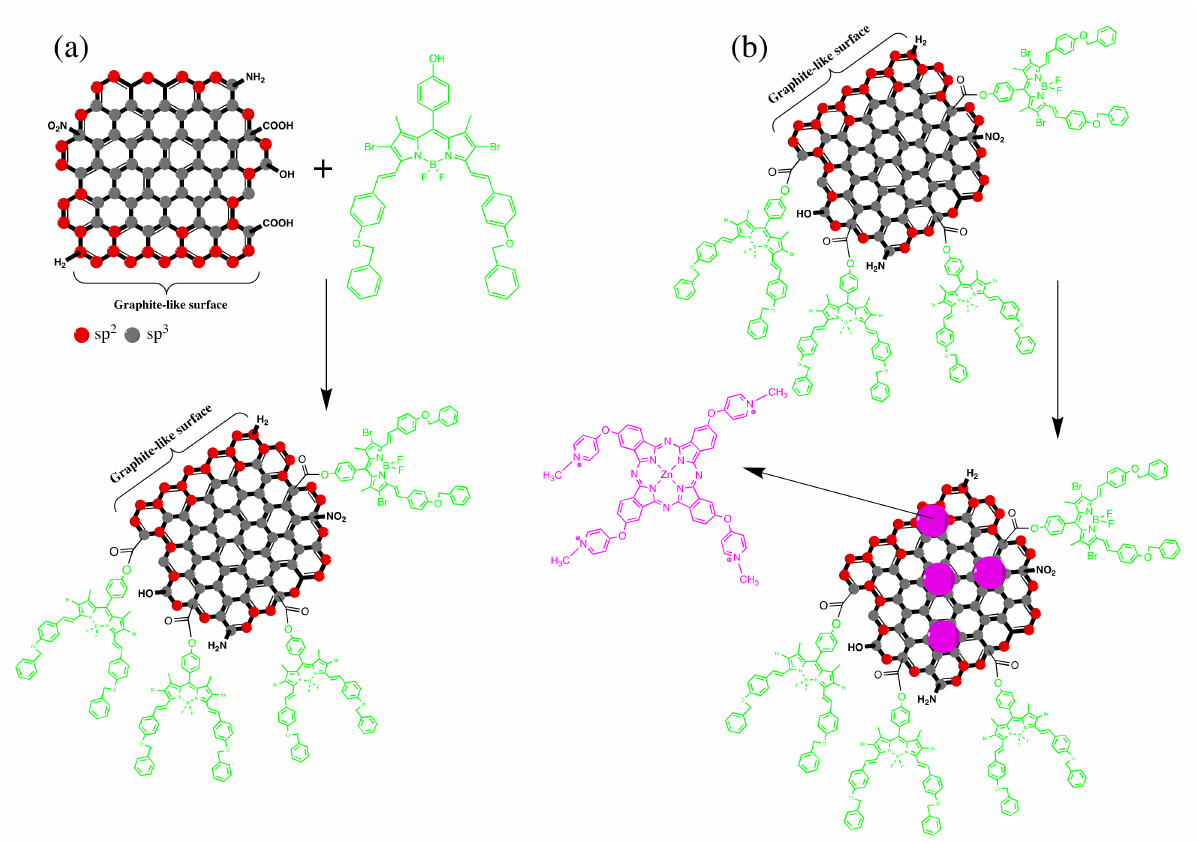
Scheme 48. Structures and synthetic route for the hybrid material of DND with BODIPY ( a ) and combined with ZnTPPcQ ( b ).